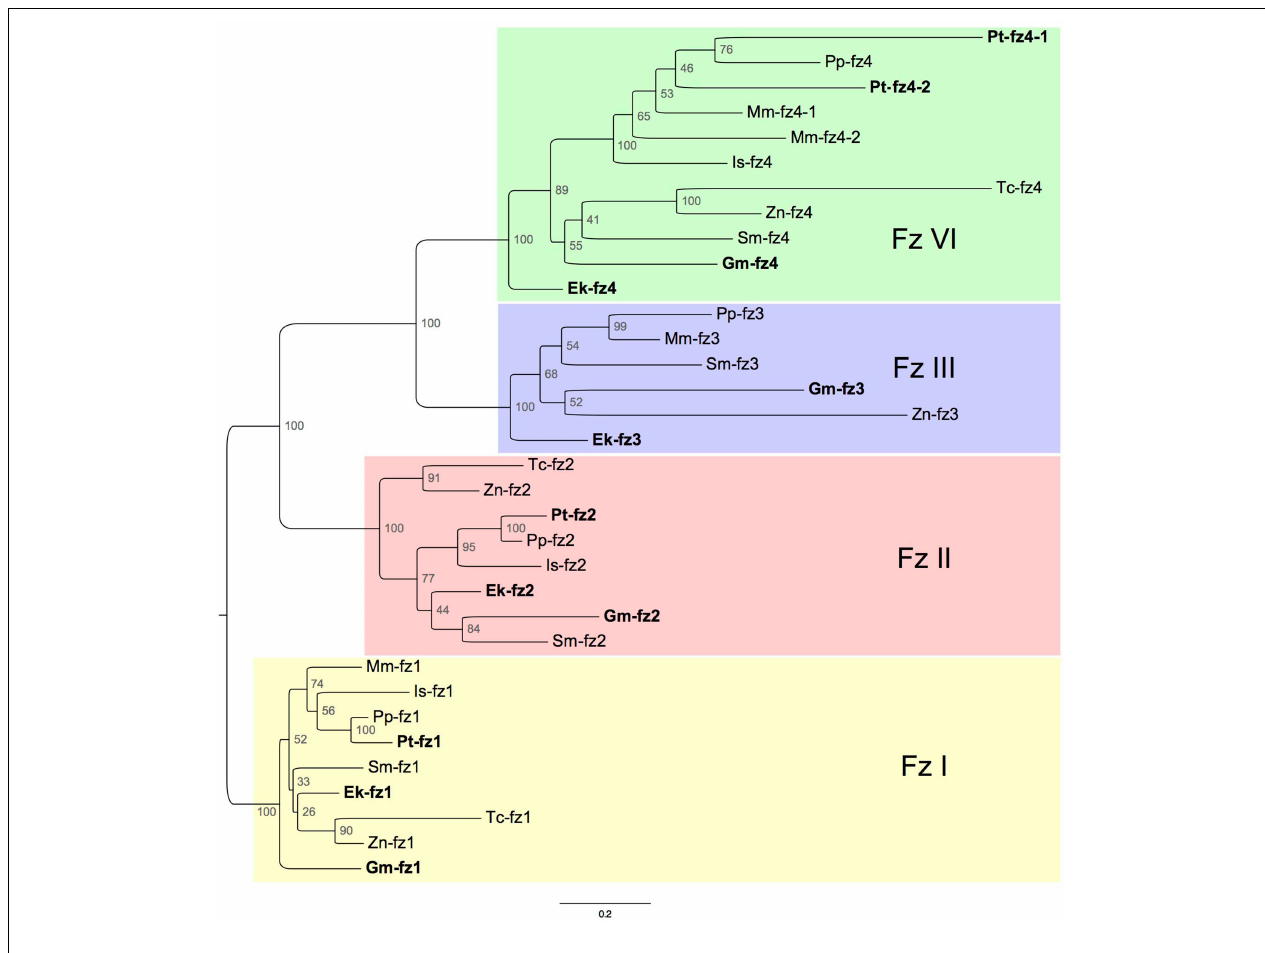
Euperipatoides kanangrensis ; Gm, Glomeris marginata ; Pt, Parasteatoda tepidariorum ; Mm, Mesobuthus martensii ; Is, Ixodes scapularis : Tc,